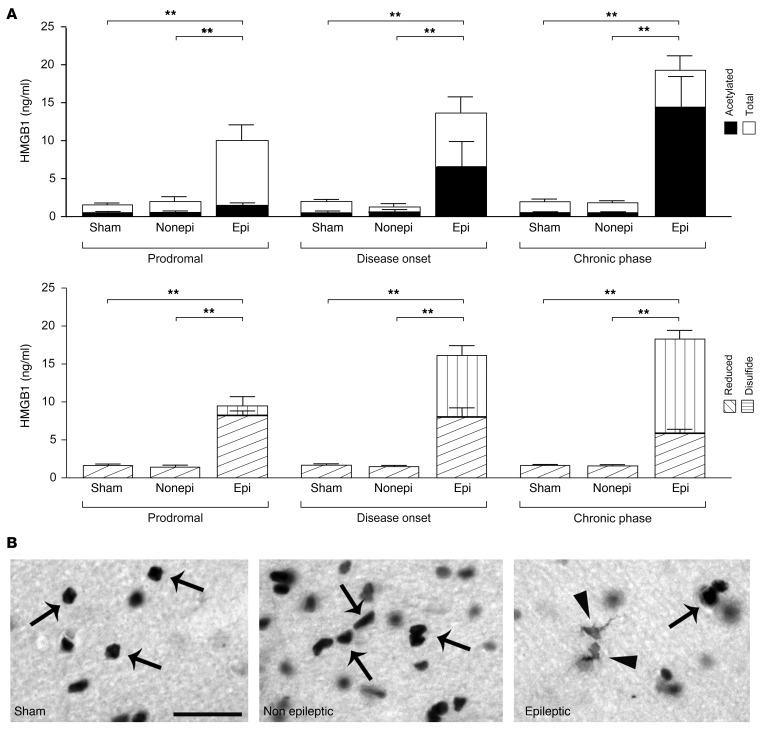
Early prediction of epilepsy development by monitoring blood HMGB1 level in lithium+pilocarpine SE rats.(A) Longitudinal analysis of total HMGB1 and acetylated, reduced, and disulfide isoform levels in blood at representative time points of disease development (see key in A). Blood was drawn at 23 days (epileptogenic phase prodromal to epilepsy onset), 73 days (encompassing the time of disease onset in 70% of rats), and 7.5 months (chronic epilepsy). Data represent mean ± SEM; n = 7 sham; n = 5 epileptic (Epi); n = 5 nonepileptic (Nonepi) rats. Dot plots are shown in Supplemental Figure 10. **P < 0.01 (refers to both isoforms in each bar); P < 0.05, acetylated HMGB1 in epileptic versus sham, Kruskal-Wallis test. Total HMGB1, acetylated and disulfide isoform levels in the chronic phase (Epi) are significantly different versus corresponding levels in prodromal phase (P < 0.01, repeated measures 1-way ANOVA). (B) Representative immunohistochemical pictures of CA1 stratum radiatum depicting HMGB1 staining in control (sham, n = 7) and in SE rats with (Epi, n = 5 out of 12) or without (Nonepi, n = 5) spontaneous seizures. Rats are the same as reported in A. Brains were harvested 7.5 months after SE. Arrows, nuclear staining of HMGB1 in sham and nonepileptic rats; arrowheads, cytoplasmic HMGB1 staining in glia in epileptic rats. Scale bar: 15 μm.